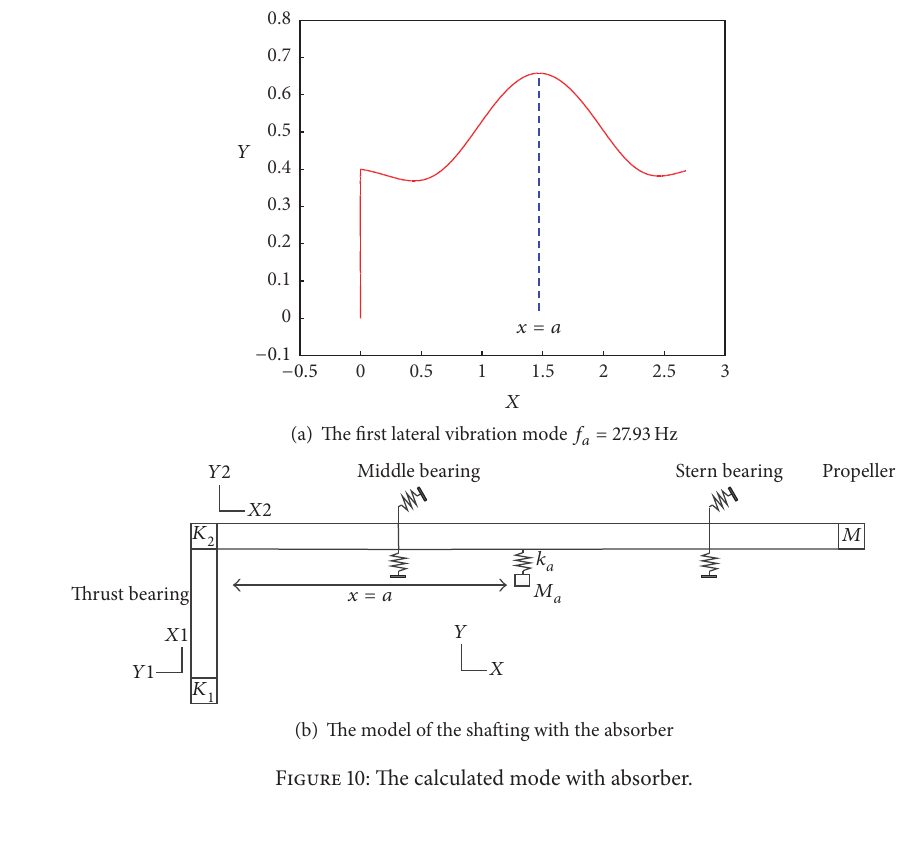
Figure 10: The calculated mode with